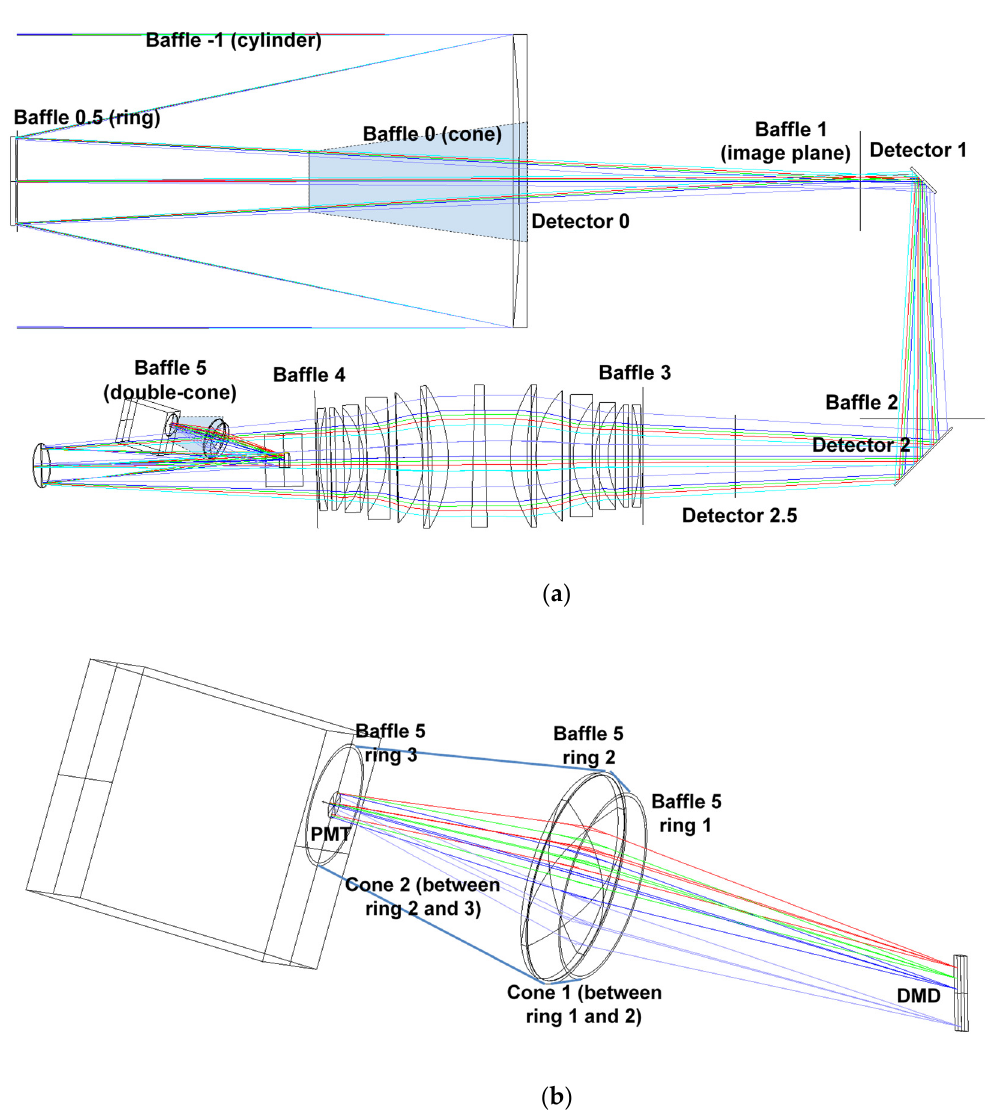
Figure 7. Stray light analysis: ( a ) positions of the baffles and detectors and ( b ) detail of the position and size of Baffle #5.